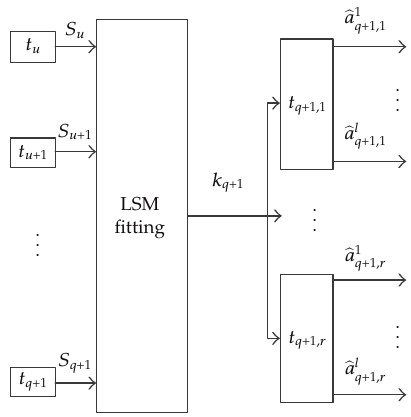
Figure 3: Illustration for predicting track irregularities of all sampling points along the unit section Sec after the (cid:2) q (cid:8) 1 (cid:3) th Track Geometry Car